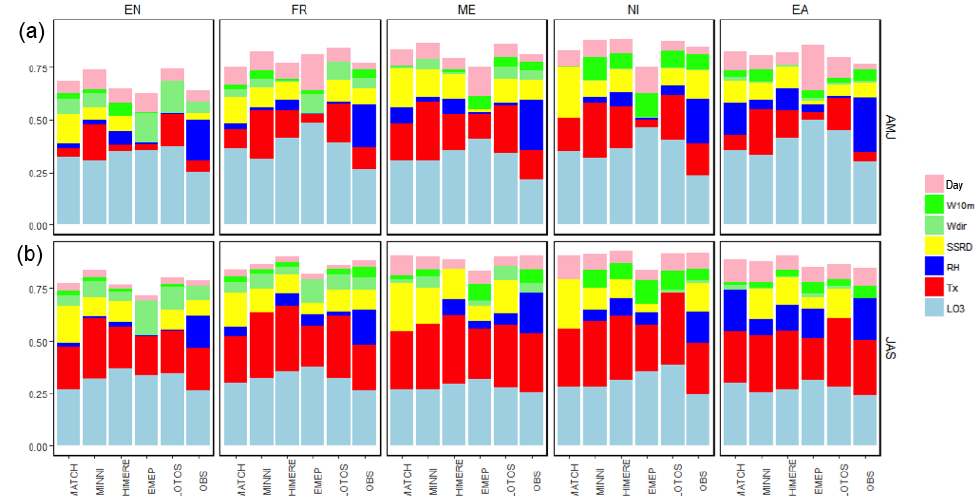
Figure 6. Proportion of each predictor to the total explained variance for each CTM-based (ordered as in Fig. 3) and observation-based MLR in AMJ (a) and JAS (b) for the internal regions: England (EN), France (FR), central Europe (ME), northern Italy (NI) and eastern Europe